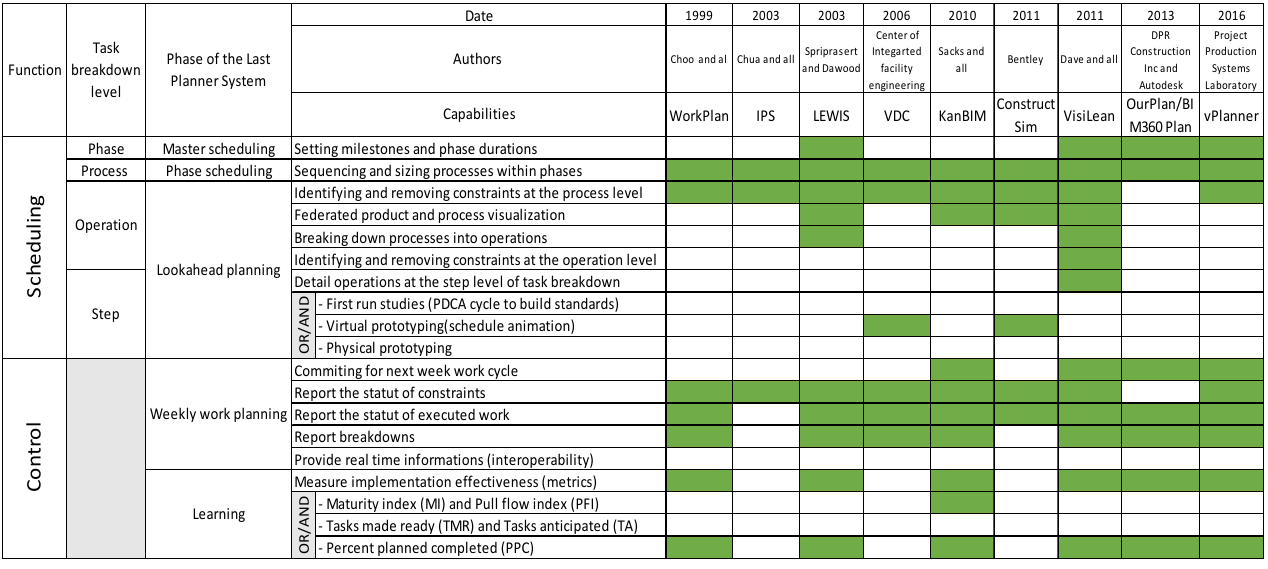
Figure 5. Capabilities of IT software supporting LPS.